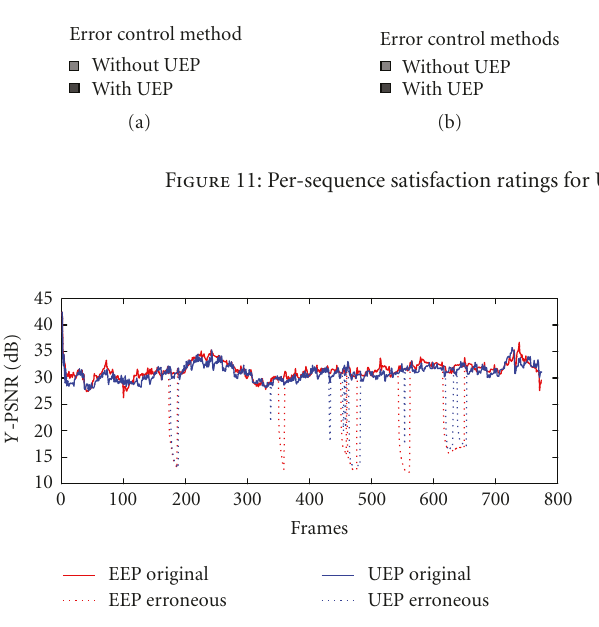
Figure 12: Per-frame PSNR for sports sequence at 13.8%